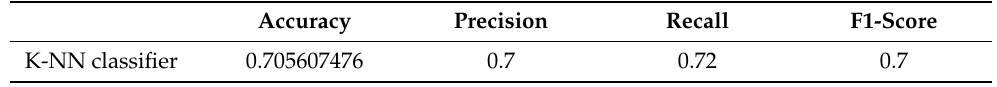
Table 4. Analysis of K-Nearest